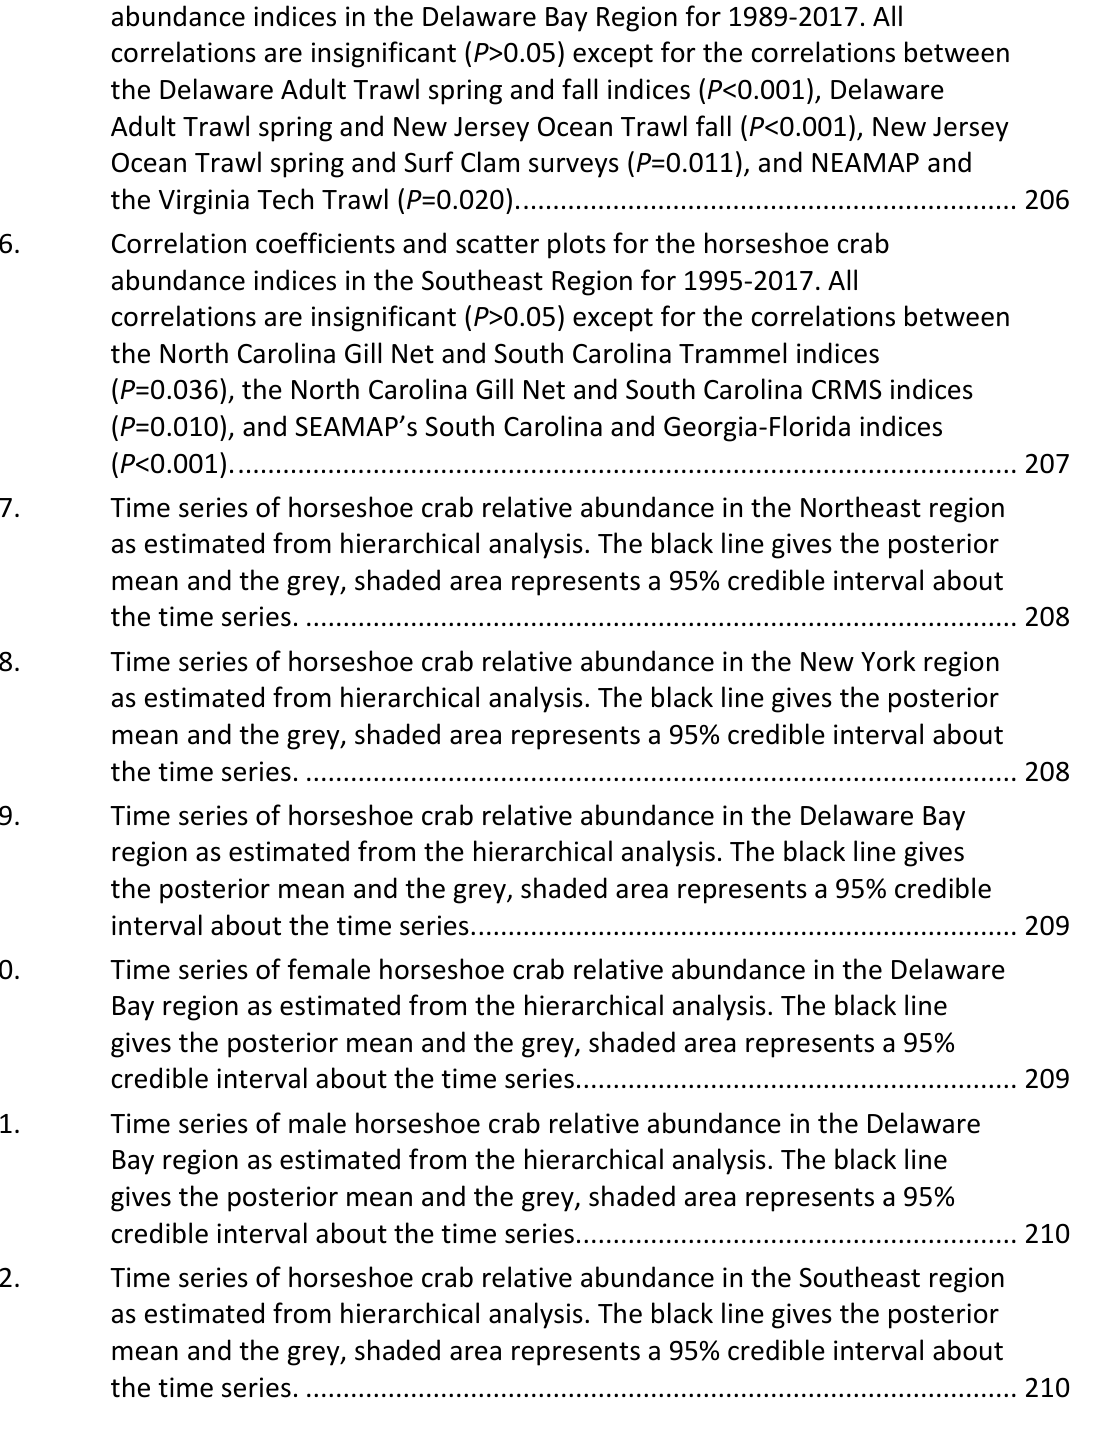
are insignificant ( P >0.05) except for the positive correlation between the